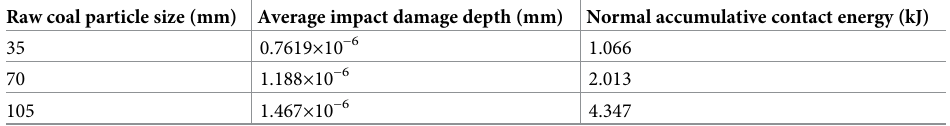
Table 9. Simulation results of the impact damage caused by the different sizes of raw coal particles.